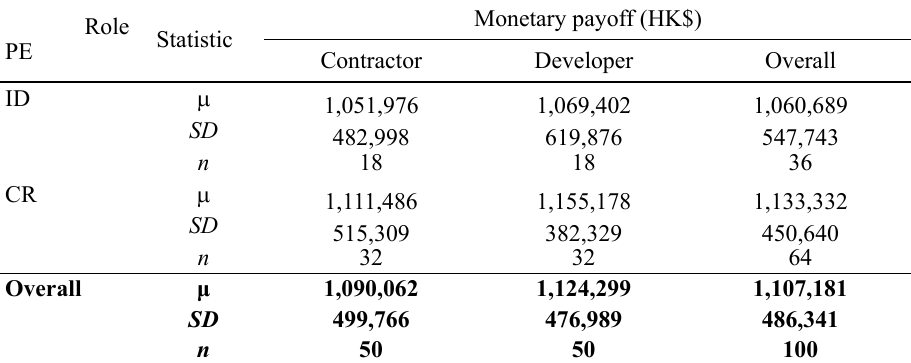
Table 5. Mean comparison of monetary and performance payoff as a function of personality and